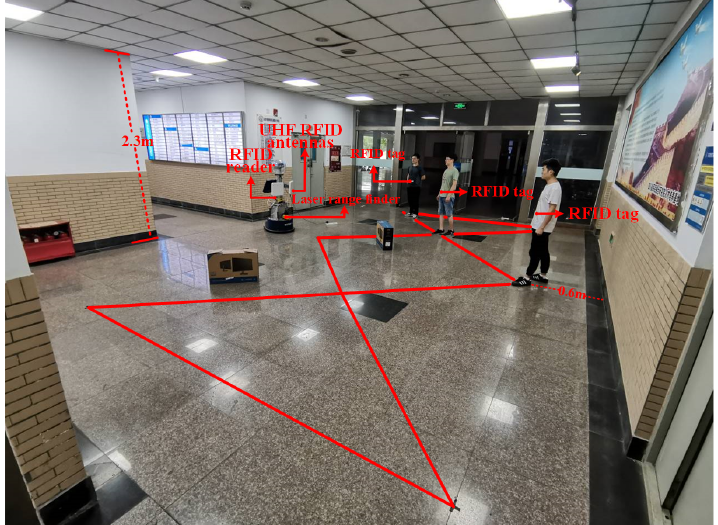
Figure 7. Complex paths results. ( a ) BC; ( b ) PF + BC; ( c ) PCC + PF + BC; ( d ) CDFs.